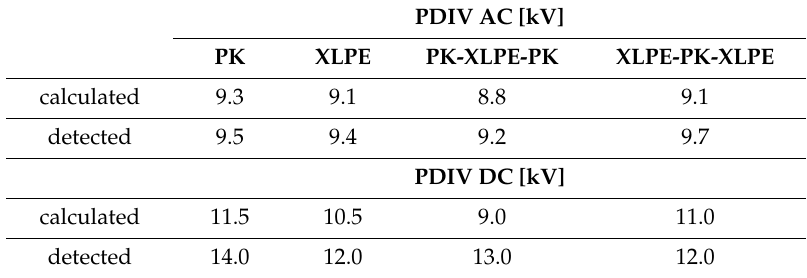
(Table 2) were used. The notation PK-XLPE-PK used in this paper means: void layer material XLPE and top / bottom layers PK. The only symbol PK or XLPE denotes the whole specimen made from the homogenous insulating material. Table 3. Partial discharge terminal inception voltage calculated and measured at AC and DC